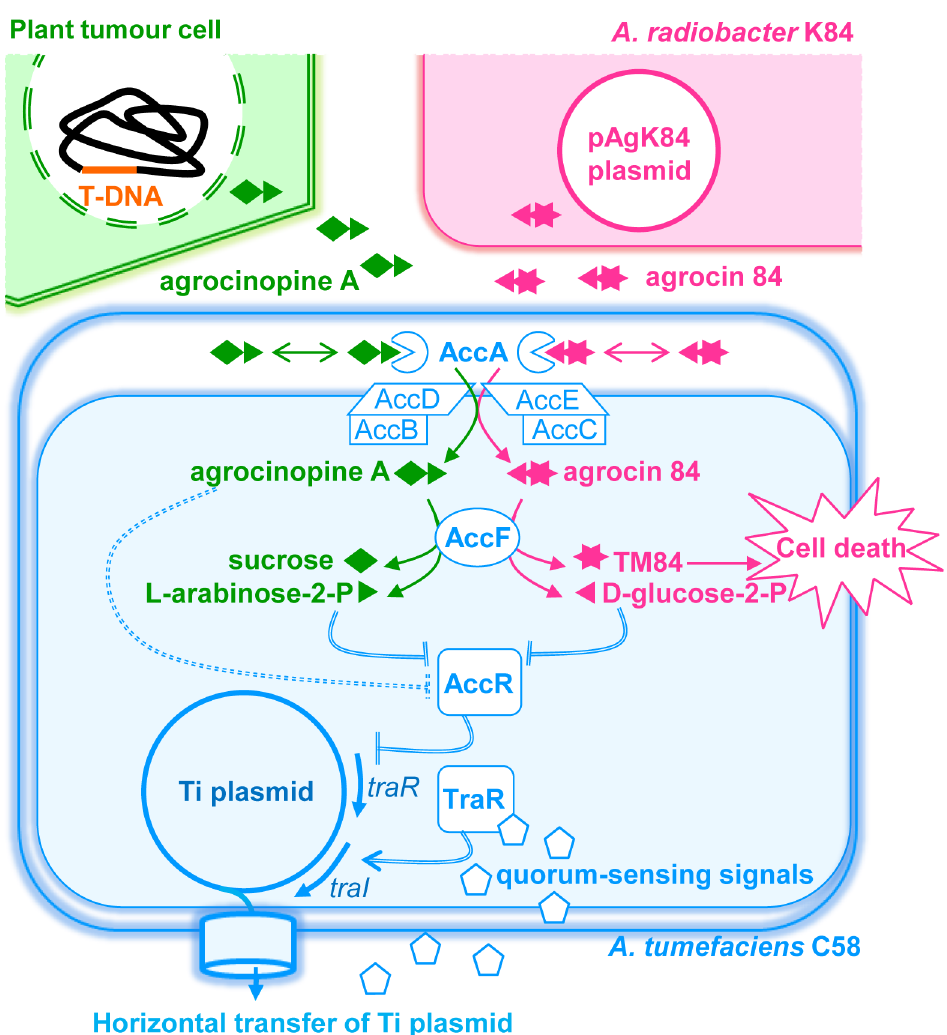
Fig 1. A simplified schematic representing the agrocinopine A and agrocin 84 roles in A . tumefaciens C58. Upon infection, virulent agrobacteria transfer a small DNA fragment (T-DNA) from its virulence Ti plasmid to the nuclear genome of the plant cells leading to genetically modified plant cells and plant-tumor formation. In plant tumor cells, the bacterial T-DNA encodes the production of opines including agrocinopine A used as nutrients and regulatory signals by agrobacteria which colonize the plant tumour tissues. Agrocinopine A is imported into the bacterial cytoplasm via the periplasmic binding protein AccA associated to a unique ABC-transporter (AccBCDE). Once in the cytoplasm, agrocinopine A is cleaved by the enzyme AccF into sucrose and L- arabinose-2-phosphate. However, Agrocin 84 produced by the non-pathogenic strain A . radiobacter K84 (which colonizes the same plant environment as the A . tumefaciens C58 pathogen) uses the same import system AccA and AccBCDE for penetrating into the cytoplasm of A . tumefaciens C58. AccF cleaves agrocin 84 into D-glucose-2-phosphate and the toxic moiety named TM84 which kills pathogen cells. In A . tumefaciens C58, agrocinopine A is proposed to interact with the transcriptional repressor AccR (dashed double lines), hence releasing acc and traR genes expression. Then, the transcriptional activator TraR interacts with quorum-sensing signals and promotes the expression of the tra , trb and rep genes which stimulate the biosynthesis of the quorum- sensing signals (traI), and amplification of copy number and conjugation of the Ti plasmid (regulation steps are indicated by double lines). In our work, we investigated the interactions between AccA and its ligands, as well as those between AccR and L-arabinose-2-phosphate and D-glucose-2-phosphate and their consequence on quorum-sensing and Ti plasmid